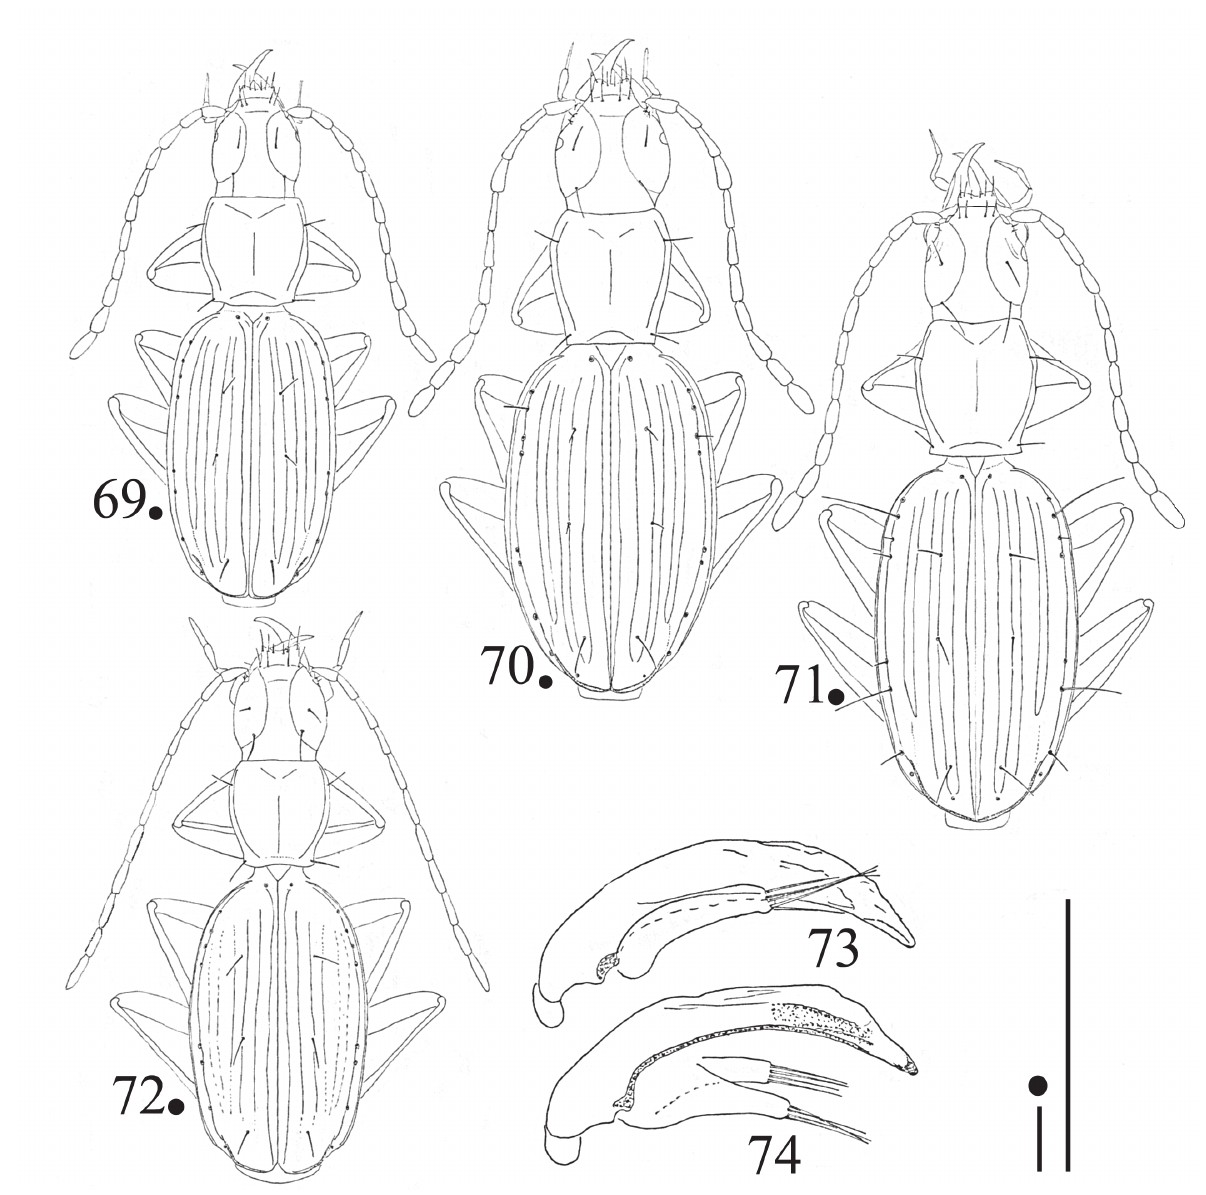
Figs 69-74. Habitus (69-72) and aedeagus in lateral view (73, 74) of Goedetrechus spp.: 69) G. minutus n. sp., HT ♀ from Niggly Cave; 70, 73) G. rolani n. sp., HT ♂ from Pendant Pot; 71, 74) G. florentinus n. sp., HT ♂ from Cauldron Pot; 72) G. damperi n. sp., HT ♀ from Damper Cave. Scale: 0.5